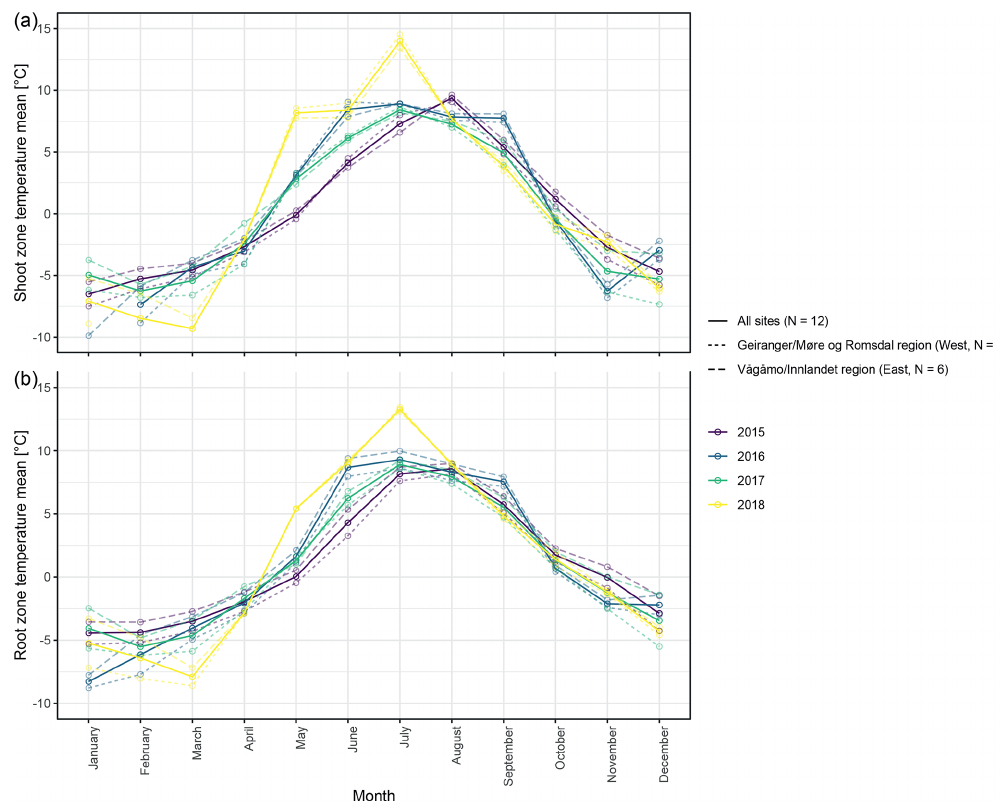
Figure 3. Mean monthly shoot (a) and root (b) zone temperatures from 2015 to 2018, for visualization purposes averaged (i) over the measured sites per study region and (ii) over all measured